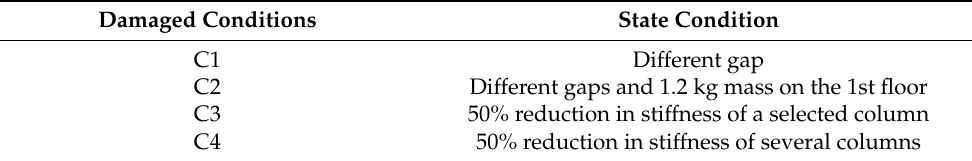
Table 1. Different state conditions of the structure.